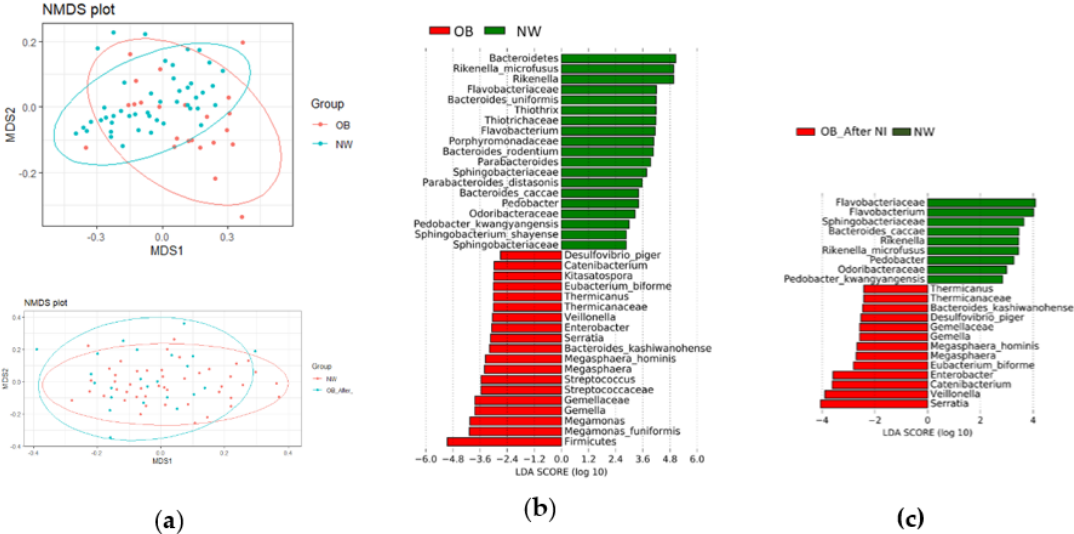
Figure 1. Diversity between obese (OB) and normal weight (NW) patients ( a ) Overweight and Figure 1. ( a ) Overweight and obesity are associated with altered beta diversity at baseline but not obesity are associated with altered beta diversity at baseline but not after a hypocaloric Mediterranean after a hypocaloric Mediterranean diet followed for three months. Three-dimensional scatter plots, diet followed for three months. Three-dimensional scatter plots, generated using the Non-Metric generated using the Non-Metric Multidimensional Scaling (NMDS) conducted on the community Multidimensional Scaling (NMDS) conducted on the community Bray–Curtis distance matrix, showed Bray–Curtis distance matrix, showed a significant separation between OB patients (OB) and normal- a significant separation between OB patients and normal-weight controls at baseline (upper panel, weight controls (NW) at baseline (upper panel, p = 0.002). After nutritional intervention (NI), the gut p = 0.002). After nutritional intervention (NI), the gut microbiota of OB did not segregate from that microbiota of OB did not segregate from that of NW (lower panel, p = 0.122). ( b ) At baseline, the of NW (lower panel, p = 0.122). ( b ) At baseline, the microbial communities of OB patients and NW microbial communities of OB patients and NW controls present distinct signatures. Results are ranked controls present distinct signatures. Results are ranked by the Linear Discriminant Analysis value by the Linear Discriminant Analysis value (LDA score): bacteria in red were more abundant in OB, (LDA score): bacteria in red were more abundant in OB, while bacteria in green were more abundant in while bacteria in green were more abundant in NW. ( c ) The NI reversed some of the microbial NW. ( c ) The NI reversed some of the microbial patterns identified at patterns identified at baseline.